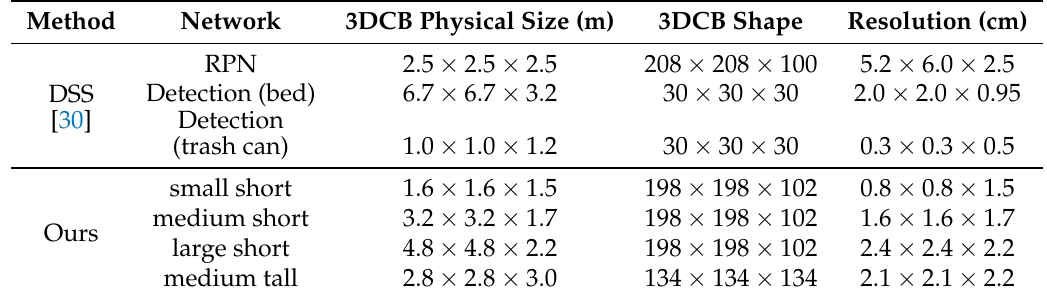
Table 2. Resolution and shape comparison between DeepSliding Shape [30] and ours. Anchors of the bed and trash can from [30] are used as examples of proposal’s physical size to make the comparison with ours.